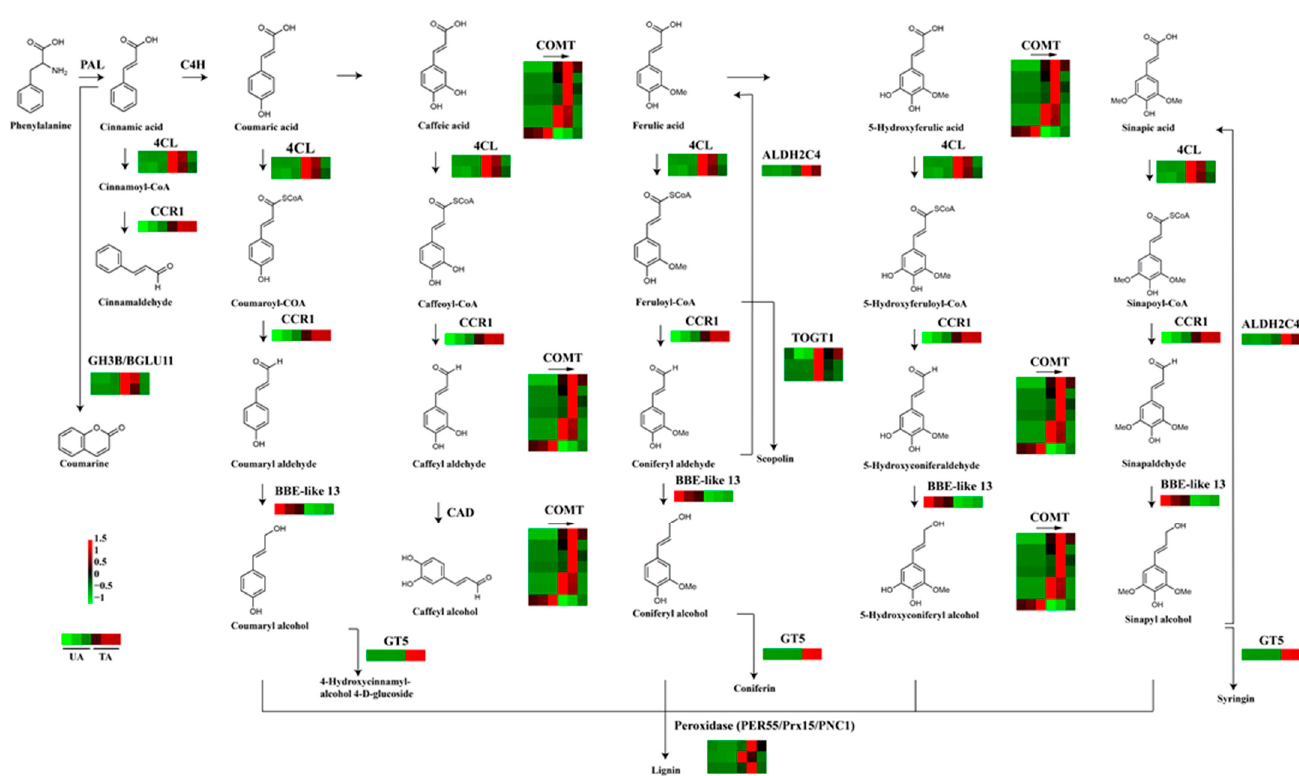
Figure 3. Expression of genes in the phenylpropanoid-biosynthesis pathway. The first three columns represent the three untreated samples, while the next three columns represent the treated samples. Red represents up-regulation and green represents down-regulation. PAL, phenylalanine